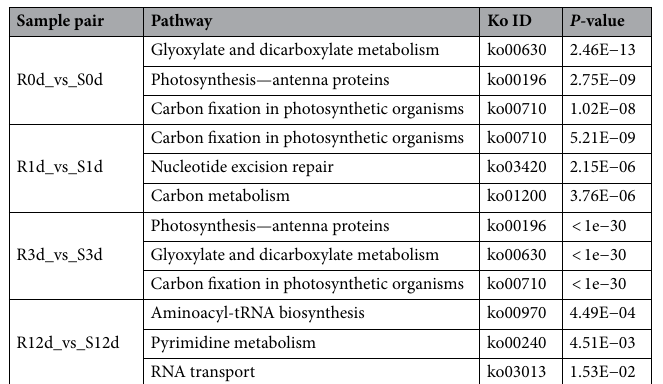
Table 1. Major enrichment pathways of the DEGs from the four timepoint groups, referencing the KEGG database. R and S are the slightly susceptible (SN4143) and highly susceptible (PZSCL6) line, respectively.